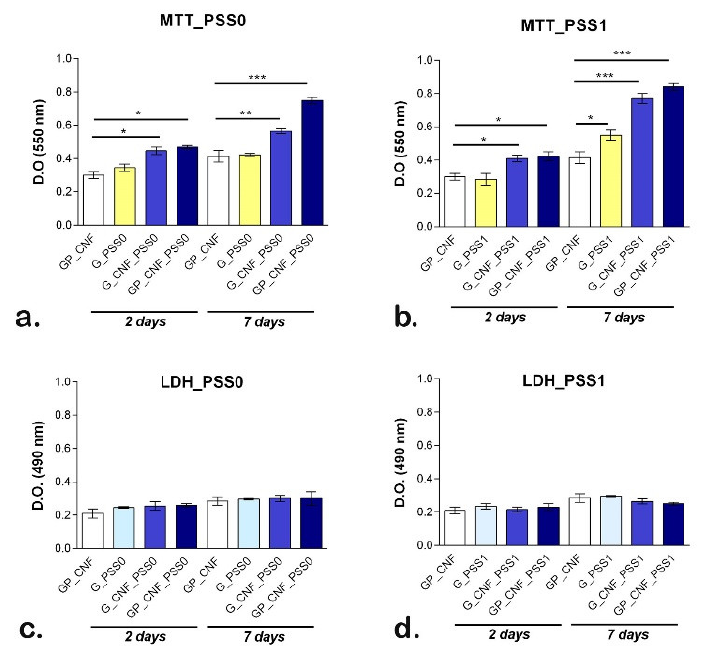
Figure 6. Assessment of biocompatibility of POSS0- and POSS1-enriched scaffolds seeded with murine preosteoblasts. ( a ) MTT assay results regarding MC3T3-E1 cells viability and proliferation after